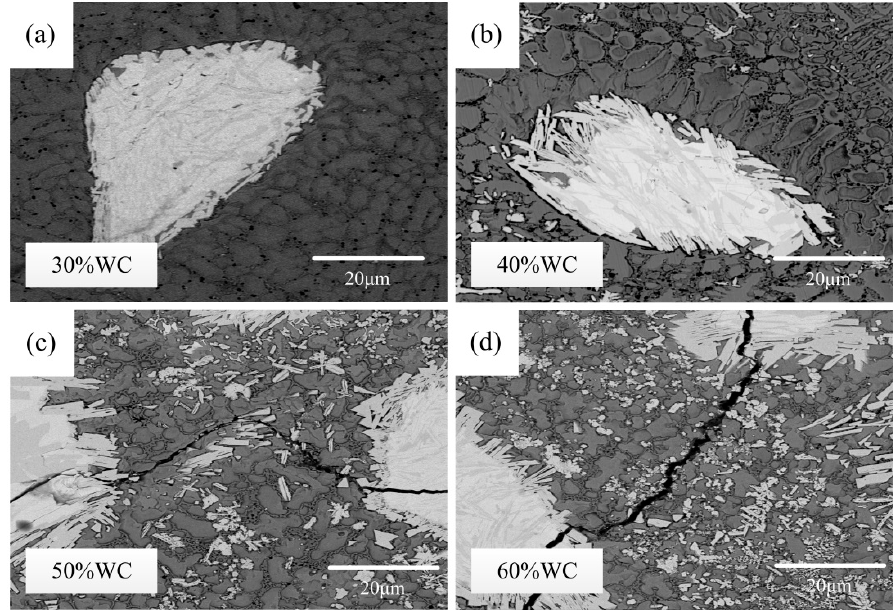
Figure 4. Surface microstructure of samples: ( a – d ) 30–60% WC